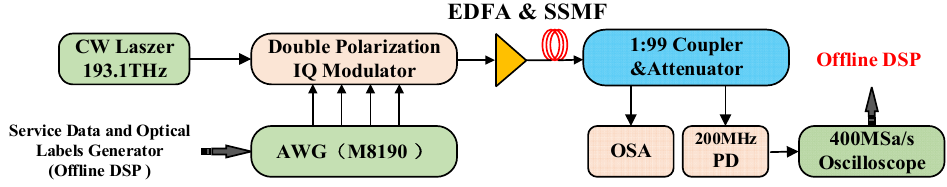
Figure 9. Diagram of experimental platform.